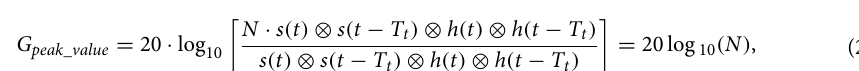
Figure 5. The LFM signal and its corresponding spindle signal. ( a ) The time domain waveform of the spindle signal and its amplitude-frequency characteristic curve. ( b ) The relationship between the ratio c of the peak values and pulse width T